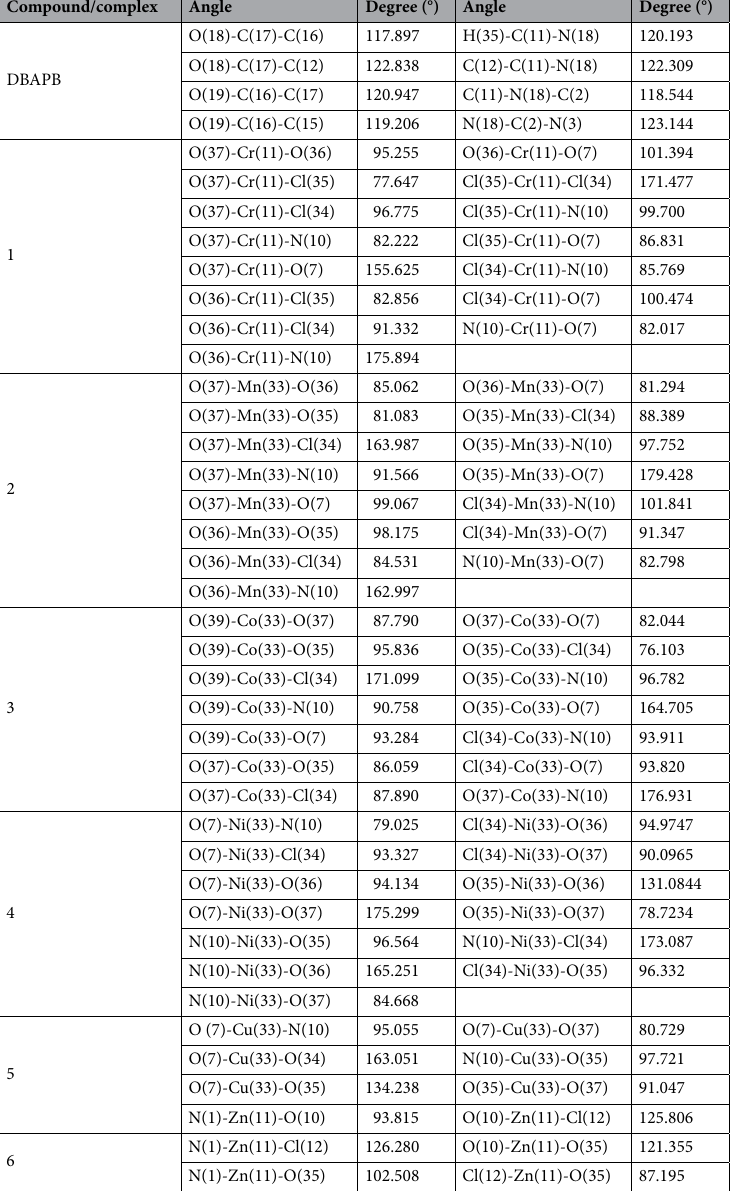
Table 6. Evaluated bond angles of the ligand, DBAPB, and its metal complexes.